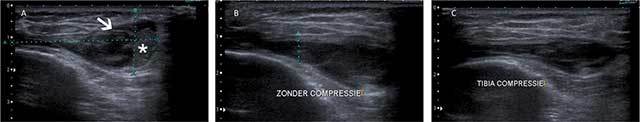
Ultrasound images of a hypoechoic heterogeneous collection in the lower leg/calf (A) with internal septations (white arrow) and fat globules (asterisk). The collection is not compressible (B–C).